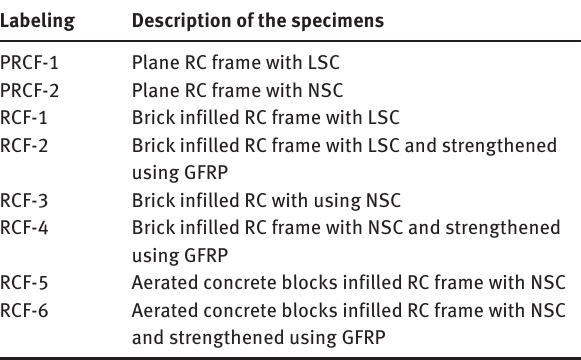
Table 1: Labeling of reinforced concrete (RC) frame test specimens.